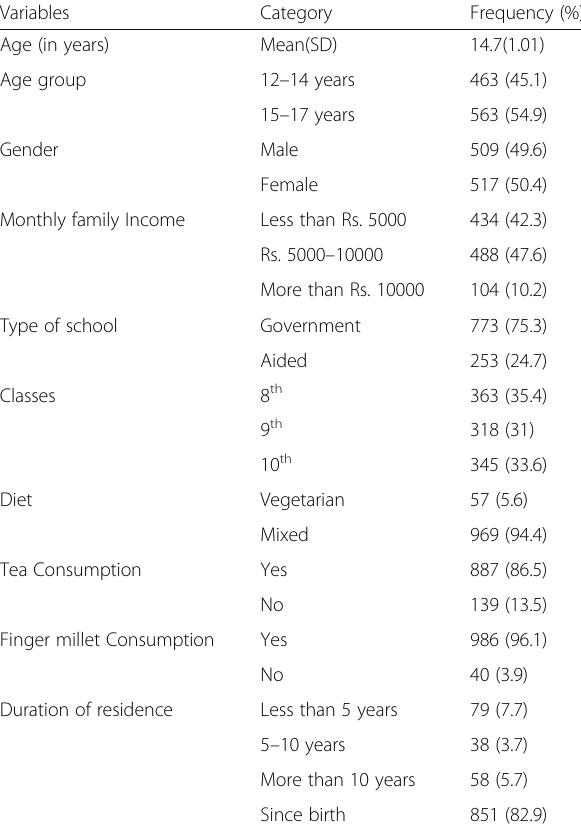
Table 1 Socio demographic characteristics of study